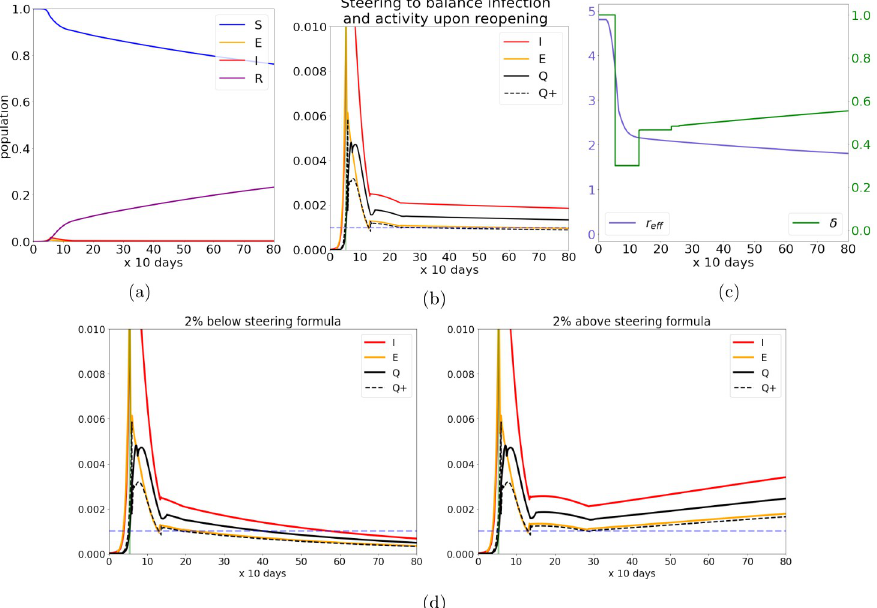
Fig 2. Steering to balance infection and activity post-lockdown. (a) and (b) show the development of the controlled epidemic as outlined in Model 1, with (a) showing a roughly linear rate of transfer from [S]usceptible to [R]ecovered and immune and (b) zooming in on the curves for the [E]xposed, [I]nfected and isolated population. Plot (c) shows the time-course of the control variable ( δ , in green) and effective reproductive number ( r eff , in blue). We can understand the epidemic response by following δ ( t ) in plot (c). After stunting the initial outbreak, the system is steered to maintain a constant level of infection. The plots in (d) showcase the sensitivity of the approximations used in the steering formula: steering at 2% above/below the prescribed formula results in growth/decay of the fraction